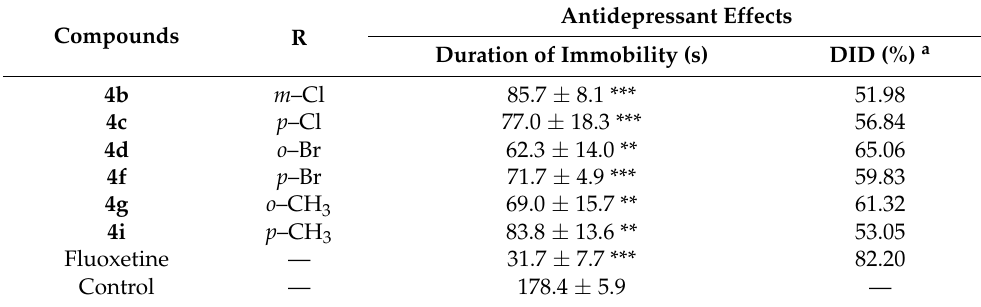
Table 4. Preliminary screening results of antidepressant activity of compounds in the FST. Antidepressant Effects Compounds R Duration of Immobility